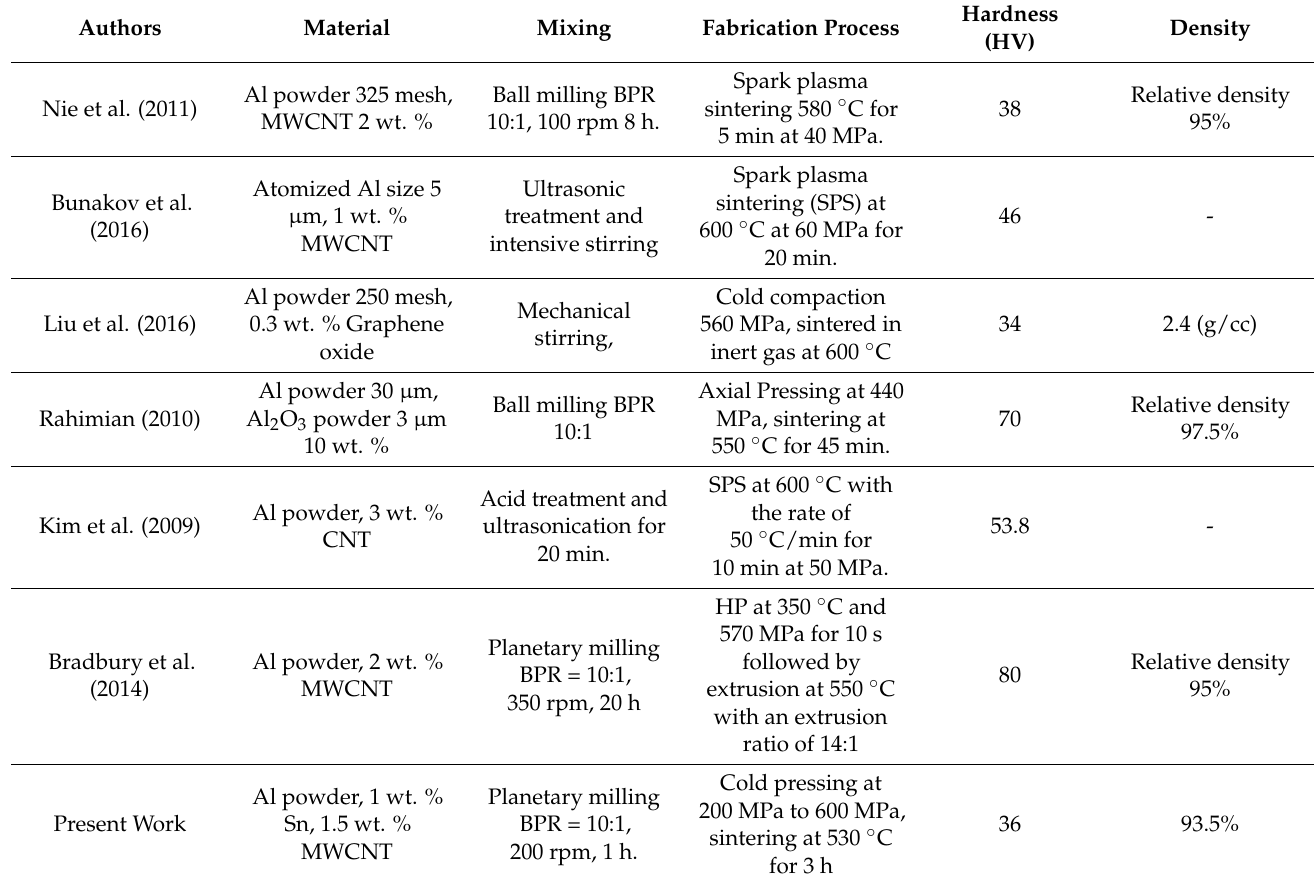
Table 2. Reported hardness and densities of Al-CNT-Sn composites fabricated by different